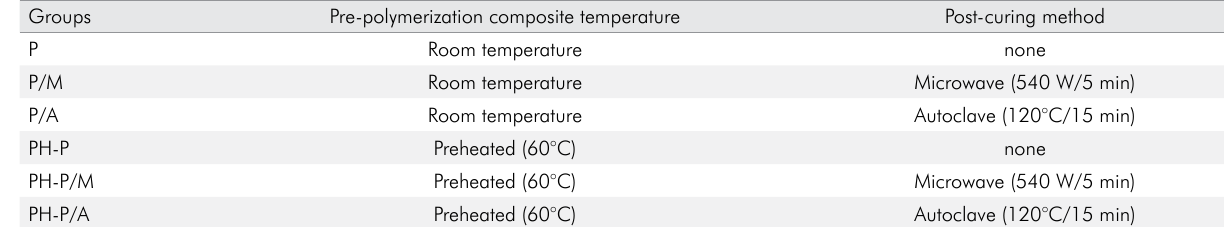
Table 2. Experimental